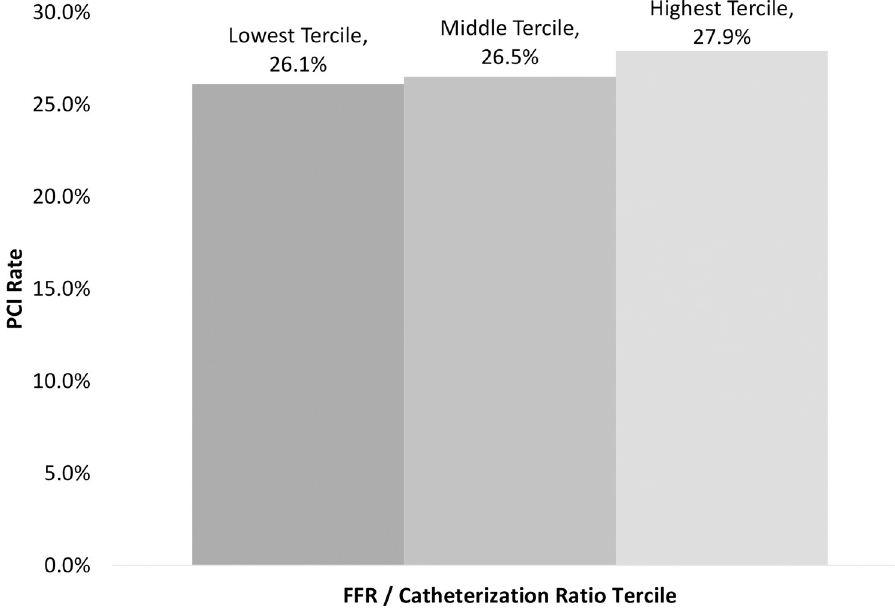
Fig 2. Relationship between a provider’s FFR / catheterization ratio tercile and PCI rate.